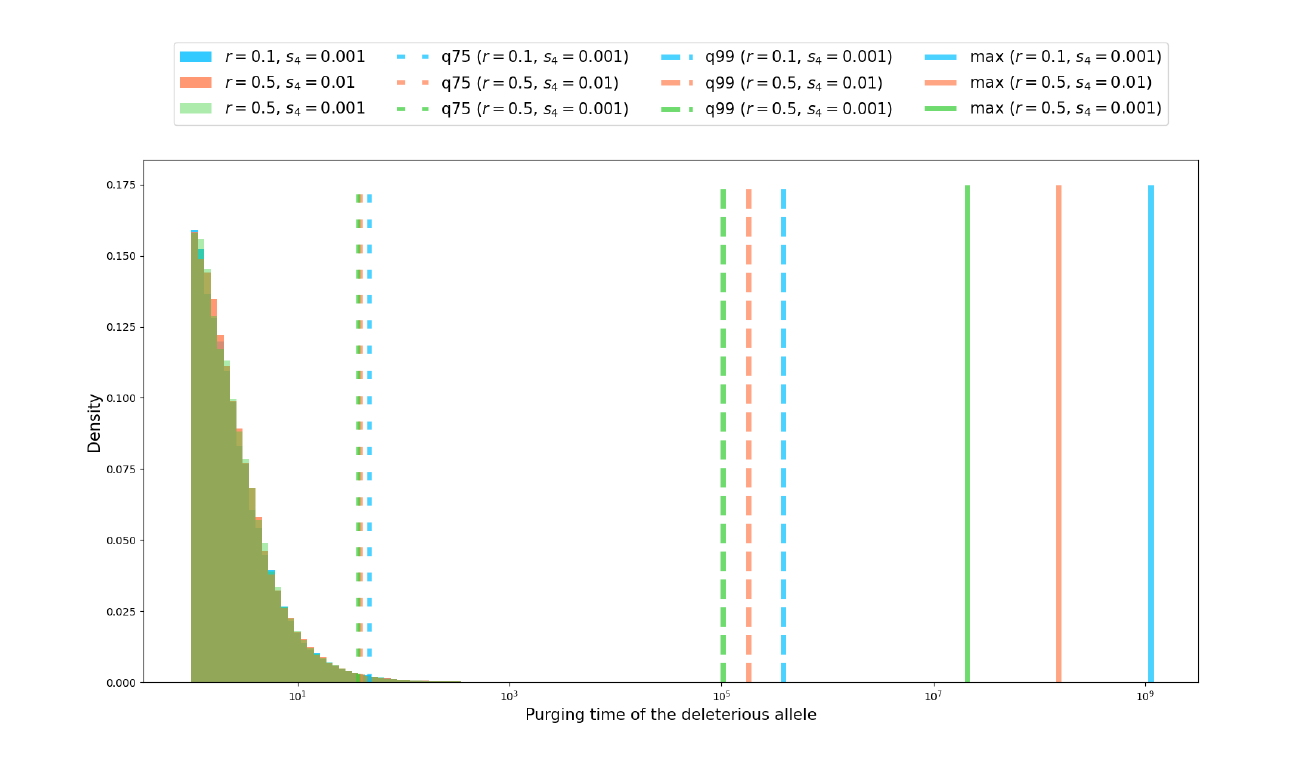
Figure S6 – Empirical distribution of the deleterious allele purging time for the over- dominance scenario. A total of 100,000 simulations were run, with s 3 = 0.1 , f = 0.5 , p in = 0.5 , starting from one heterozygous individual ( X 0 = (1, 0, 0) ), for several values of the recombination rate and of the selection coefficient s 4 ( r = 0.1, s 4 = 0.001 in blue, r = 0.5, s 4 = 0.01 in red, and r = 0.5, s 4 = 0.001 in green). The respective values for ρ 0.0052 , ρ = 0.0129 and ρ = 0.0219 . The parameters were chosen so that are ρ = − − − the process is sub-critical and thus the purging time is almost surely finite. The x-axis is th log-scaled. The large-dotted lines represent the 75 percentile ( q75 ), the dashed lines th indicate the 99 percentile ( q99 ), and solid lines the maximum value ( max ) of the purging time. Maximum values are several order of magnitudes higher than the 75 th percentile of the empirical distribution of the purging